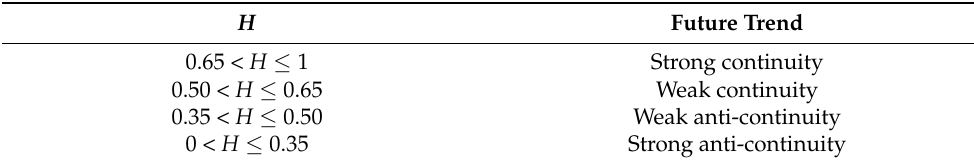
Table 2. Future trend detected by Hurst